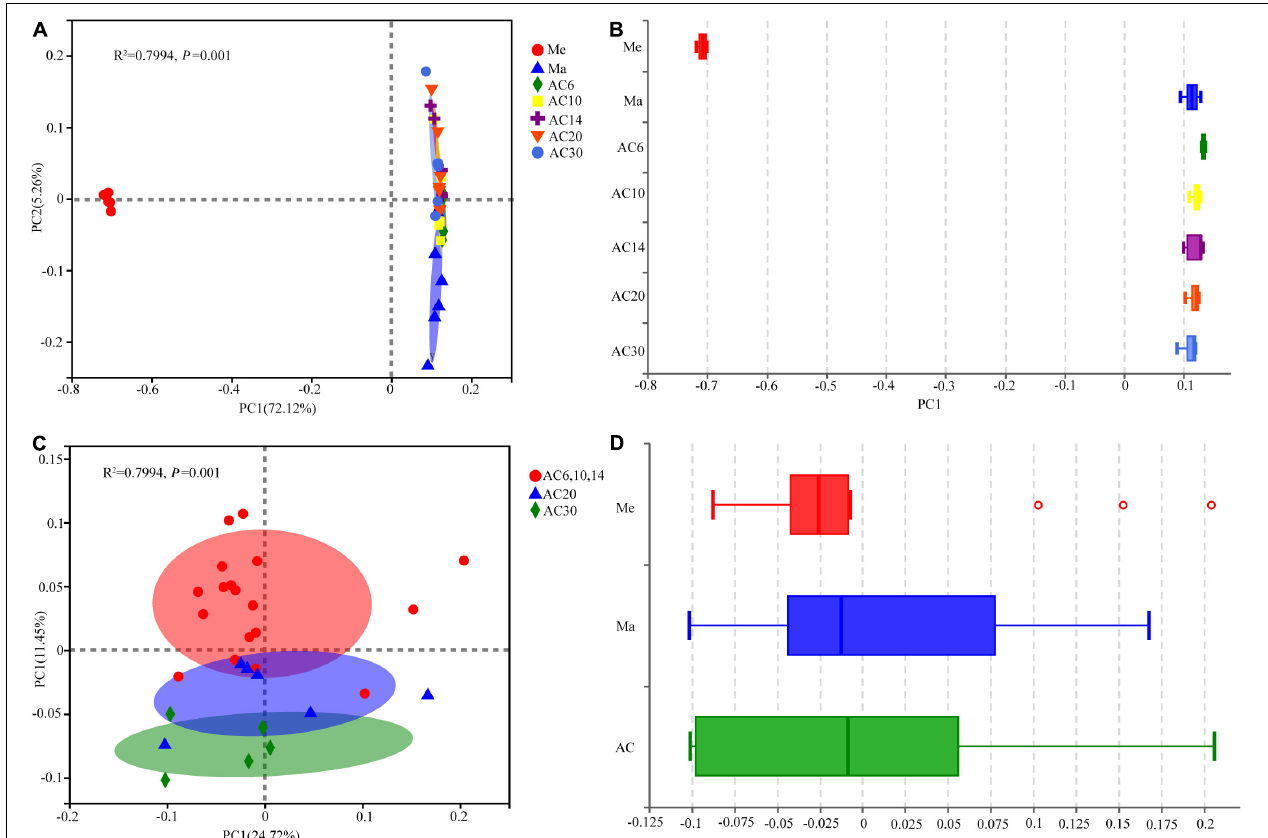
FIGURE 3 | Principal coordinate analysis (PCoA) based on Bray–Curtis dissimilarities in the soil among the seven treatments (A,B) and among alfalfa continuous cropping different years (C,D) .